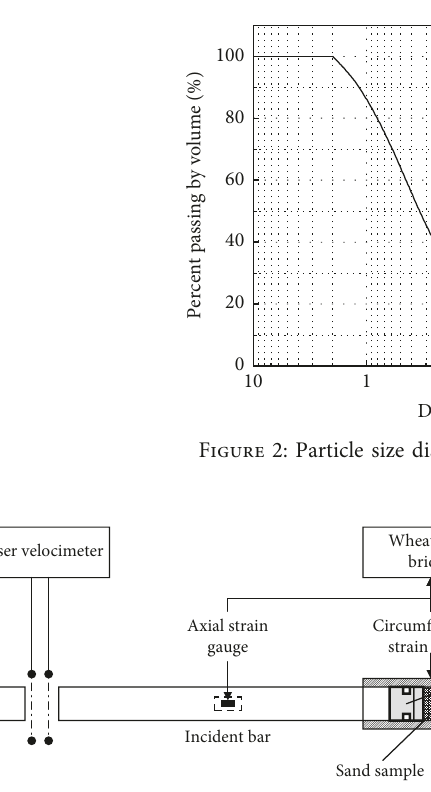
Figure 3: Schematic of the SHPB apparatus used for dynamic compaction of